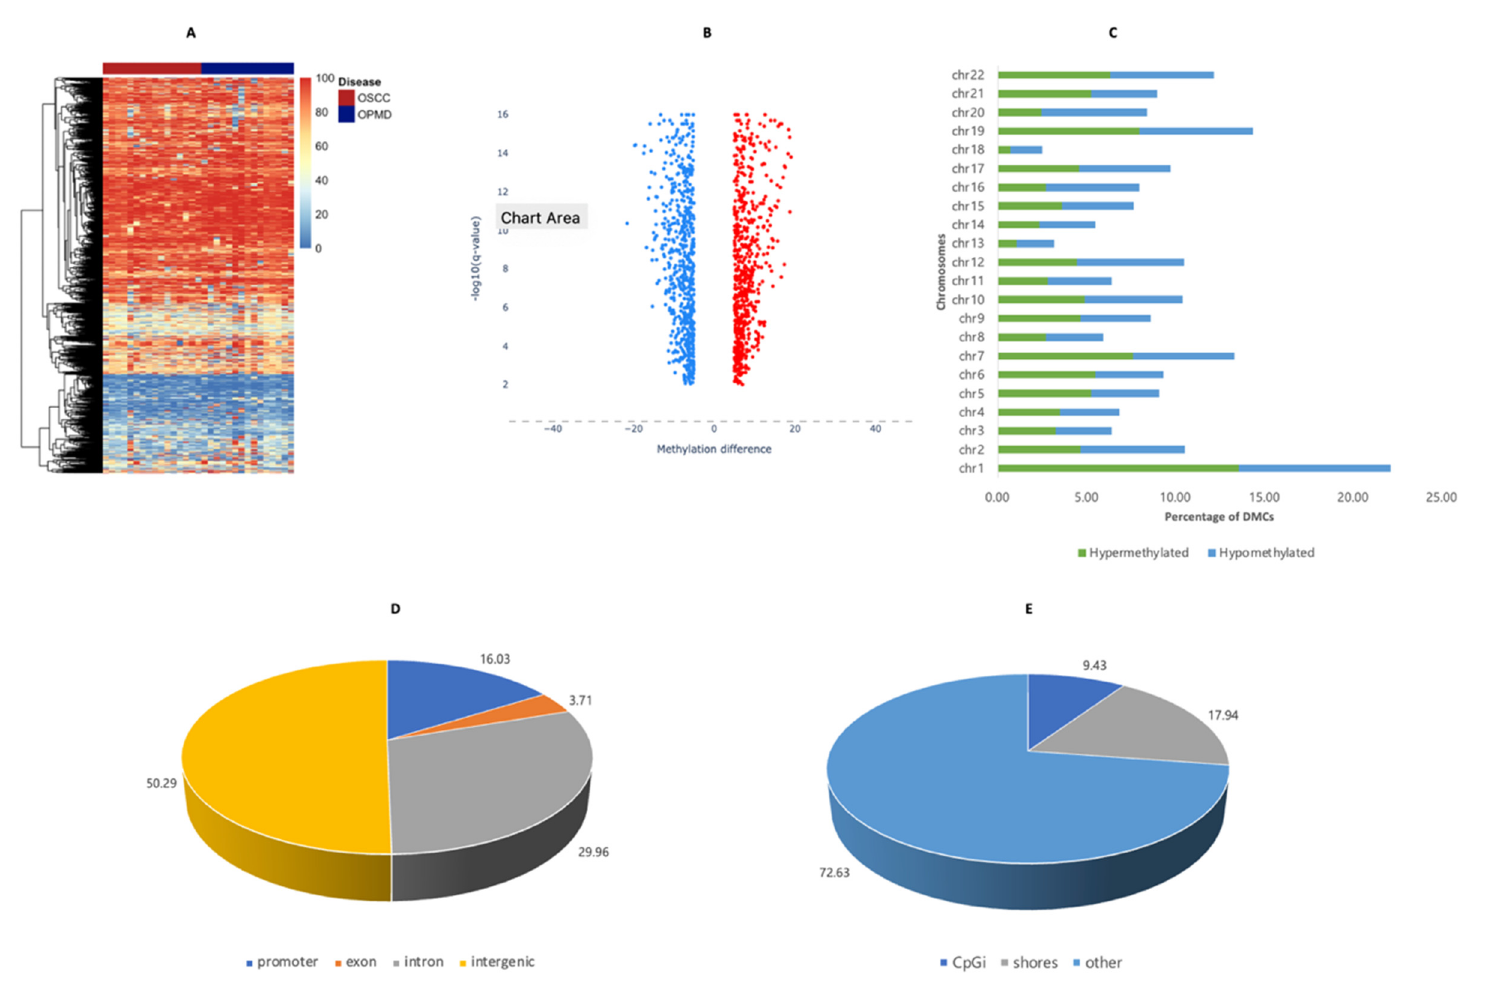
Figure 1. Base-pair resolution analysis for identification and description of DMCs. ( A ) Heatmap comprising the methylation percentages of differential CpG sites for all samples ( B ) Volcano plot of weighted mean methylation difference for hypermethylated (red) and hypomethylated (blue) DMCs ( C ) Autosomal annotation